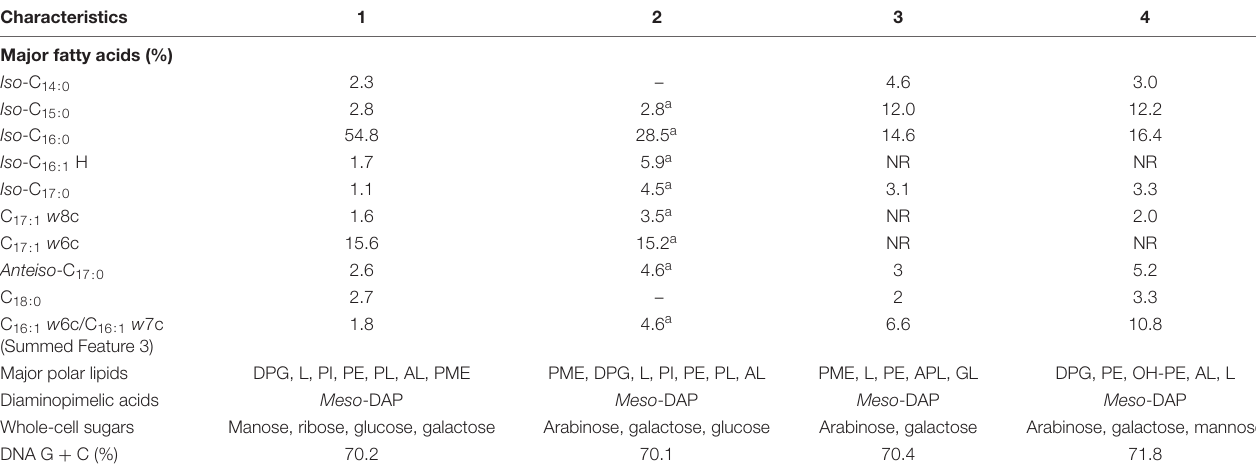
TABLE 2 | Differentiation of the chemotaxonomic characteristics between strain YIM 96748 T , Amycolatopsis cihanbeyliensis BNT52 T , Amycolatopsis jiangsuensis KLBMP 1262 T , and Amycolatopsis suaedae 8-3EHSu T . Characteristics 1